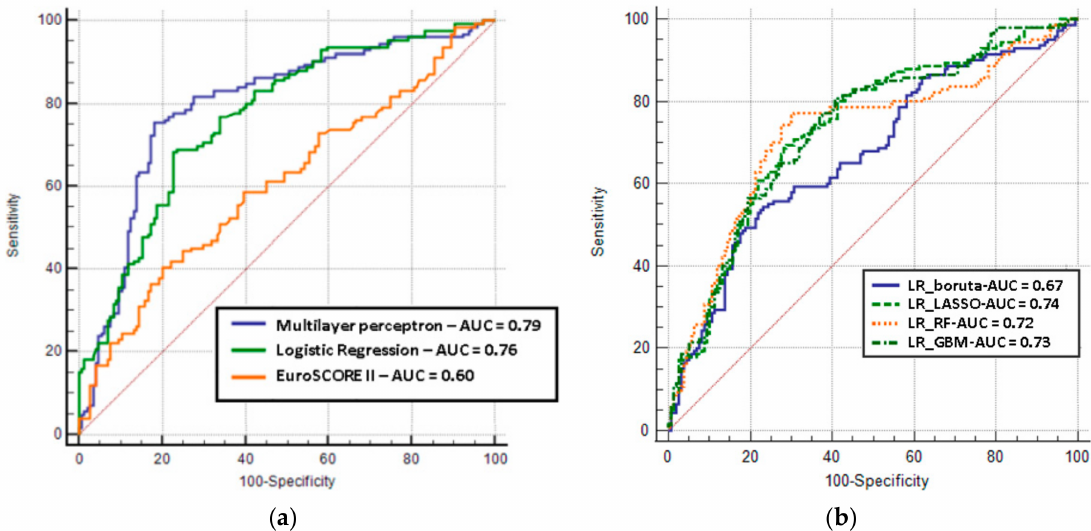
Figure 4. Receiver operating characteristic curves for prediction of 5-year mortality: ( a ) multilayer perceptron vs. logistic regression vs. EuroSCORE II, ( b ) logistic regression models using different feature selection methods. AUC, area under the curve; LR, logistic regression; GBM, gradient boosting machine; RF, random forest; LASSO, least absolute shrinkage and selection operator.